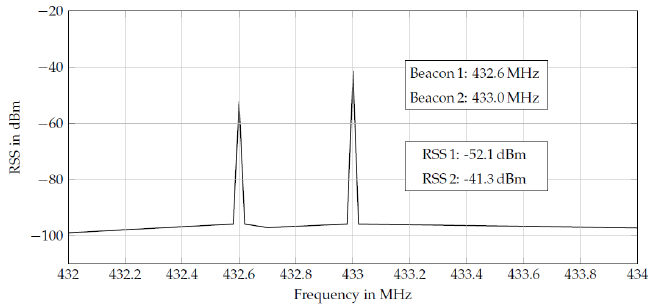
Figure 7. Signals from two beacons emitting at 432.6MHz and 433.0MHz. The receiver identifies the